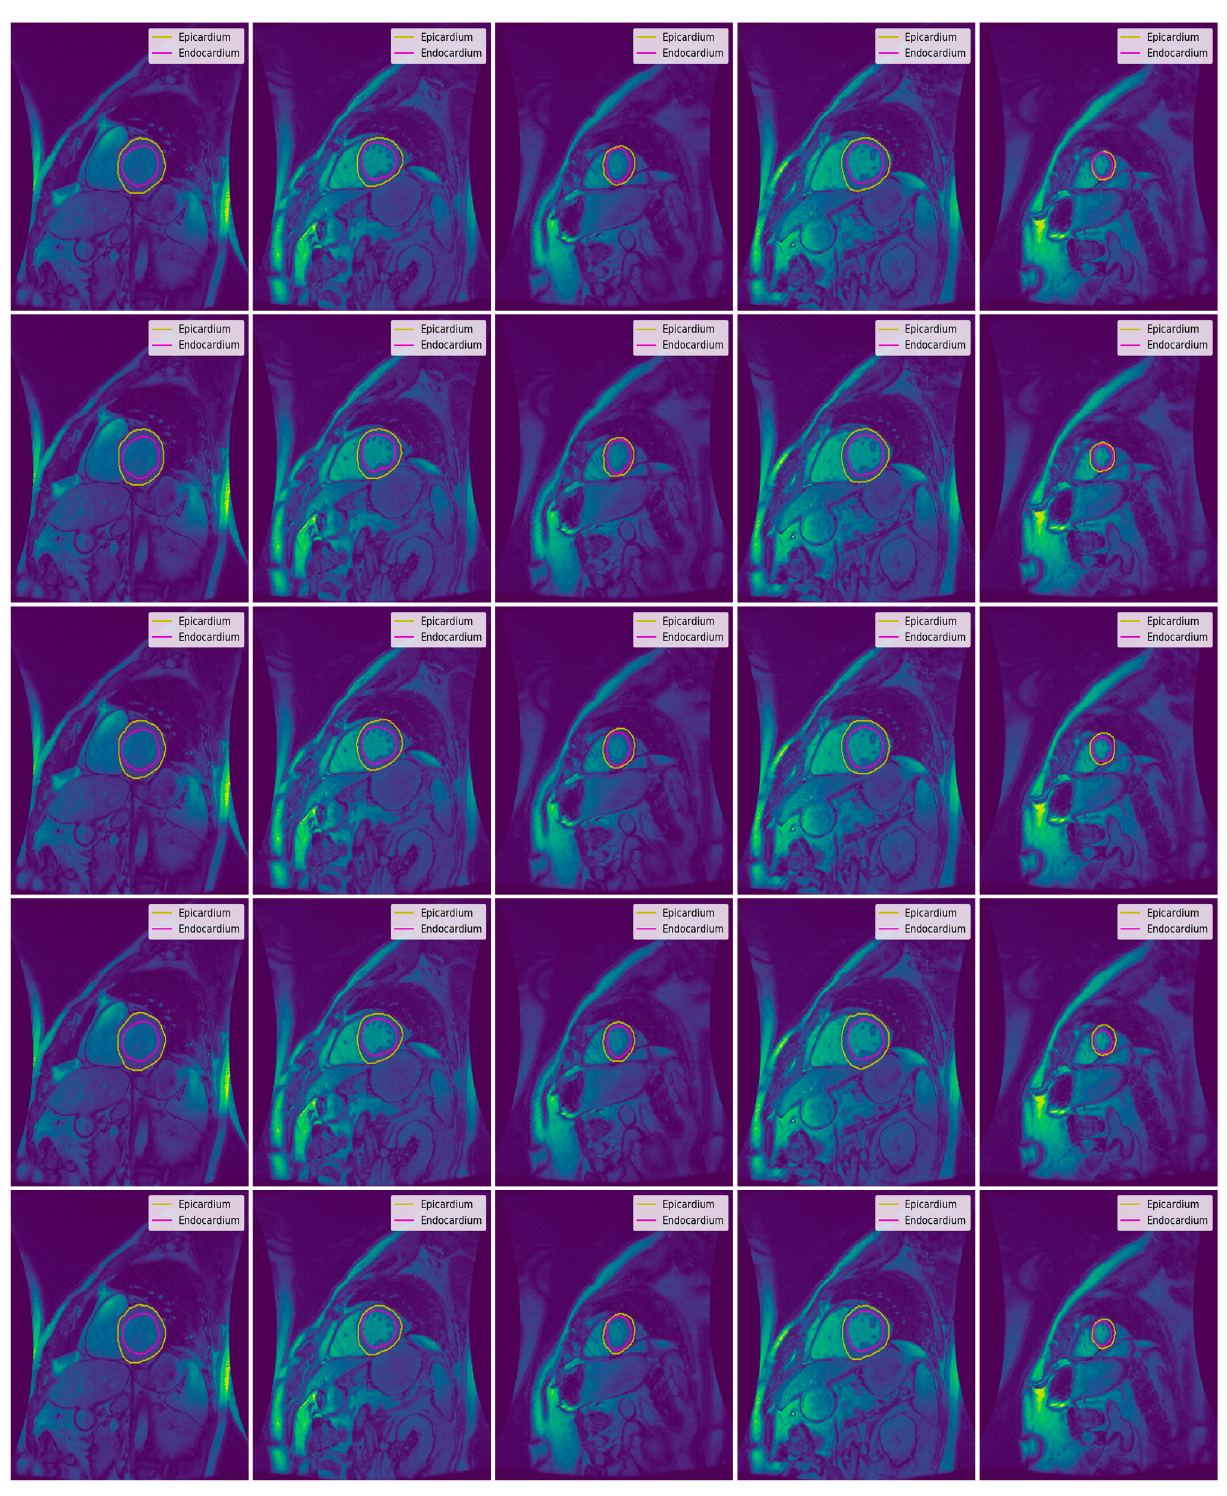
Figure 19. Automatic segmentation results of epicardium and endocardium boundaries from the training set of a normal patient (SC-N).